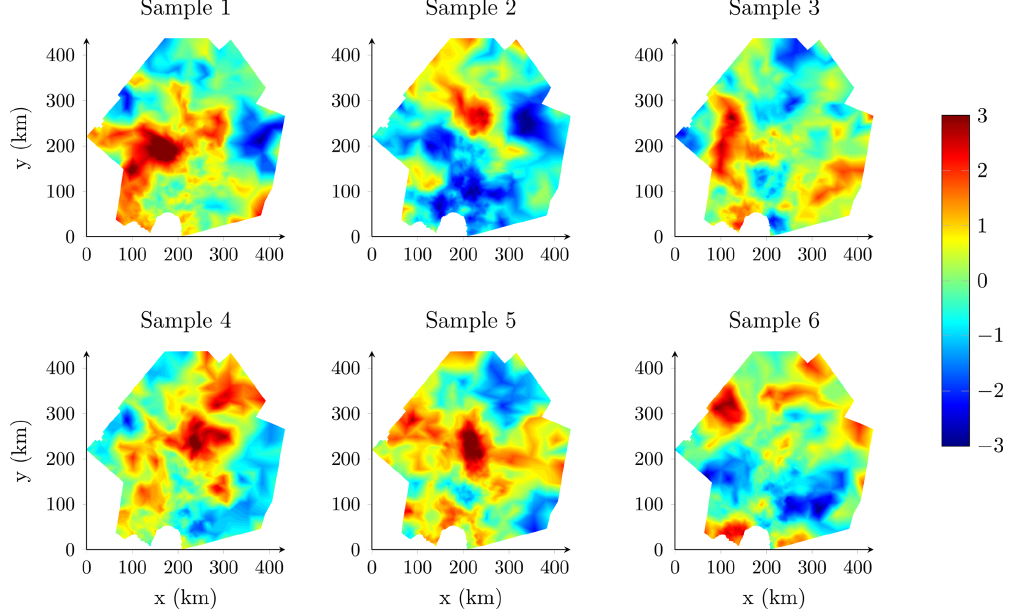
Figure 8. The same as Fig. 6 but with a parameter range of 100km. For comparison, the SPDE (Eq. 2) is solved with the same realizations of the right-hand side as in Fig.